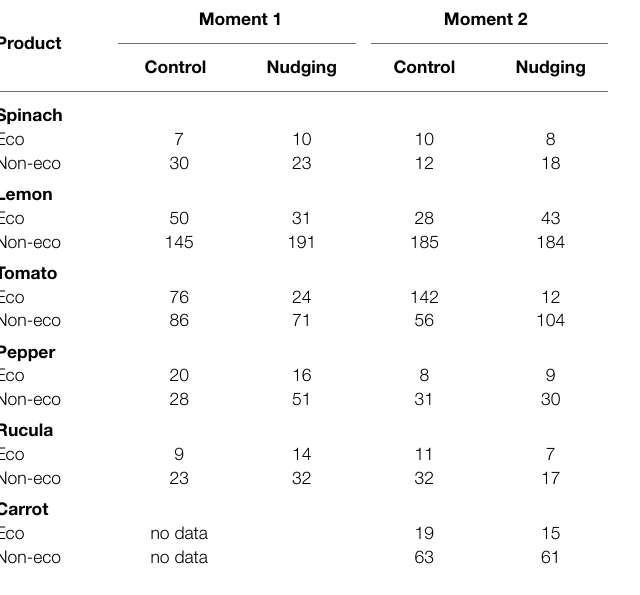
TABLE 1 | Quantity of sold products (ecological or non-ecological), for each condition (control and nudging), in the first or the second period of the experiment.